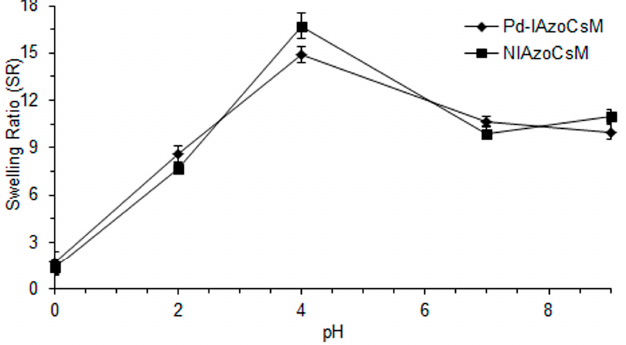
Figure 6. Equilibrium swelling ratio versus pH values of imprinted and non-imprinted membranes.